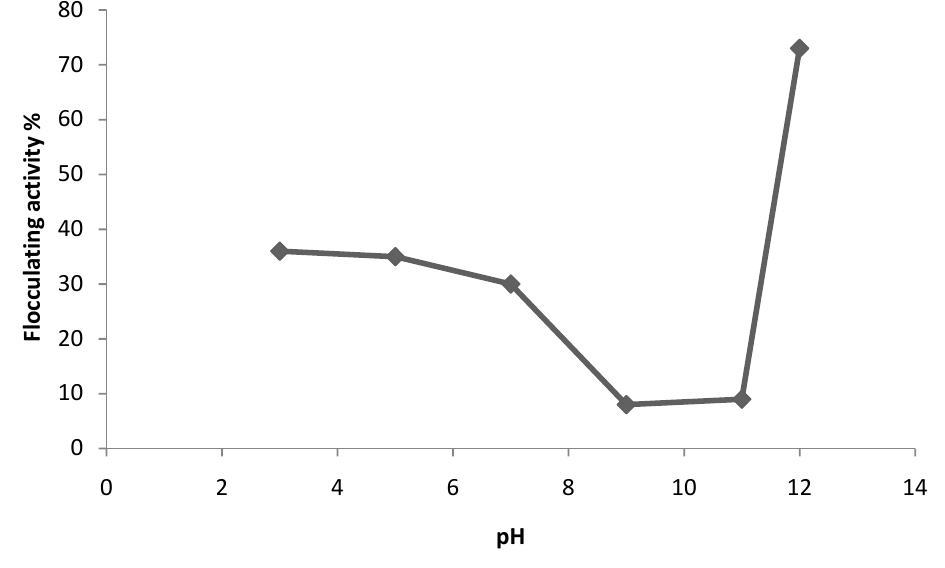
Figure 2. Effect of initial pH of cultivation medium on bioflocculant production by Virgibaccilus sp.